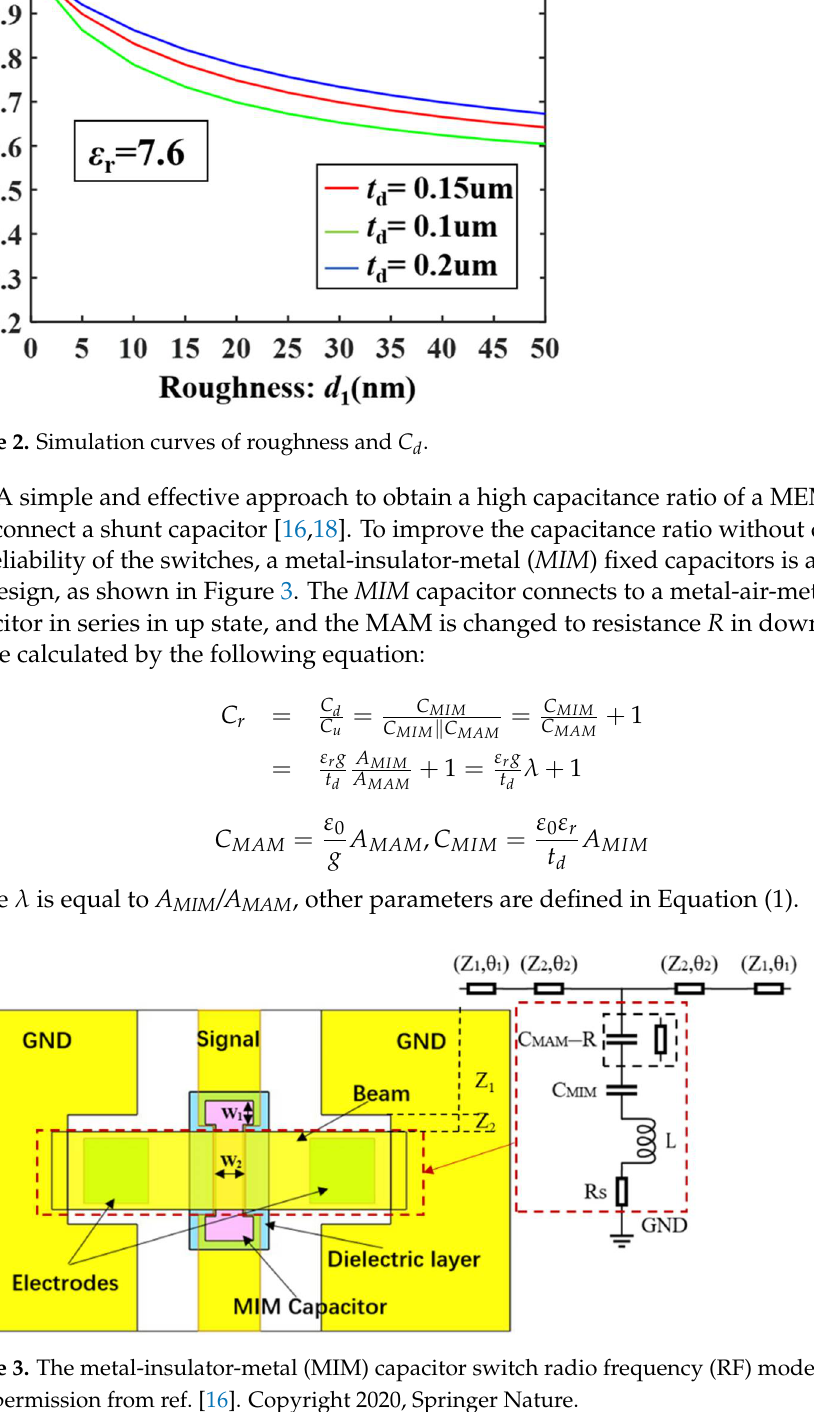
( b ) Figure 4. C r with and without MIM. ( a ) the relationship between C r and w 1 . ( b ) the relationship between Cr and w 2 [16]. It can be seen from the Figure 3 that the MIM capacitor can effectively improve the capacitance ratio of the switch. When w 1 = 10 μm, C r is increased with the increase of the value of w 2 . And when w 2 = 30 μm, C r is decreased with the increase of the value of w 1 . It can be found that C r = 206 with g = 2 μm, t d = 0.15 μm, w 1 = 10 μm, w 2 = 30 μm. 2.2. Low Spring Constant Bending Folding Beam Switch Design and Pull-Down Model Due to the small amount of deformation, the switch beam can be equivalent to a rigid body, and its mechanical properties can be described by linear elastic coefficients [16]. A simple and effective approach to obtain a low actuation voltage of a MEMS switch is to reduce the spring constant of the beam. This paper designs a switch structure as shown in Figure 4a. In order to reduce the spring constant, the switch uses a bending folding beam,